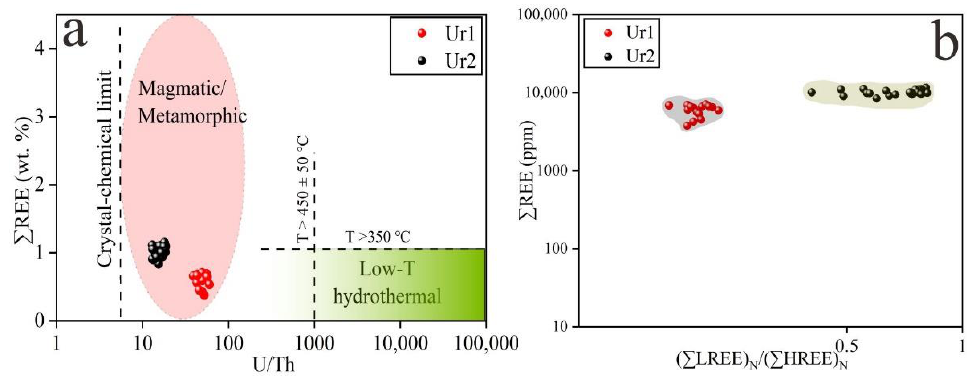
Figure 12. ( a ) Plot of ∑REE versus U/Th for the Ur1 and Ur2 uraninite from the Datian uranium deposit [42]. ( b ) Plot of ∑REE versus LREE (La -Eu)/HREE (Gd-Lu) for the Ur1 and Ur2 uraninite from the Datian uranium deposit [43]. Normal- deposit [42]. ( b ) Plot of ∑ REE versus LREE (La-Eu)/HREE (Gd-Lu) for the Ur1 and Ur2 ization values from Anders and Grevesse [44].